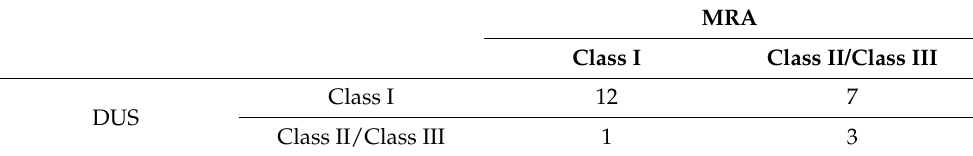
Table 3. Cross modality comparison between DUS and MRA in diagnosing aneurysm reperfusion.